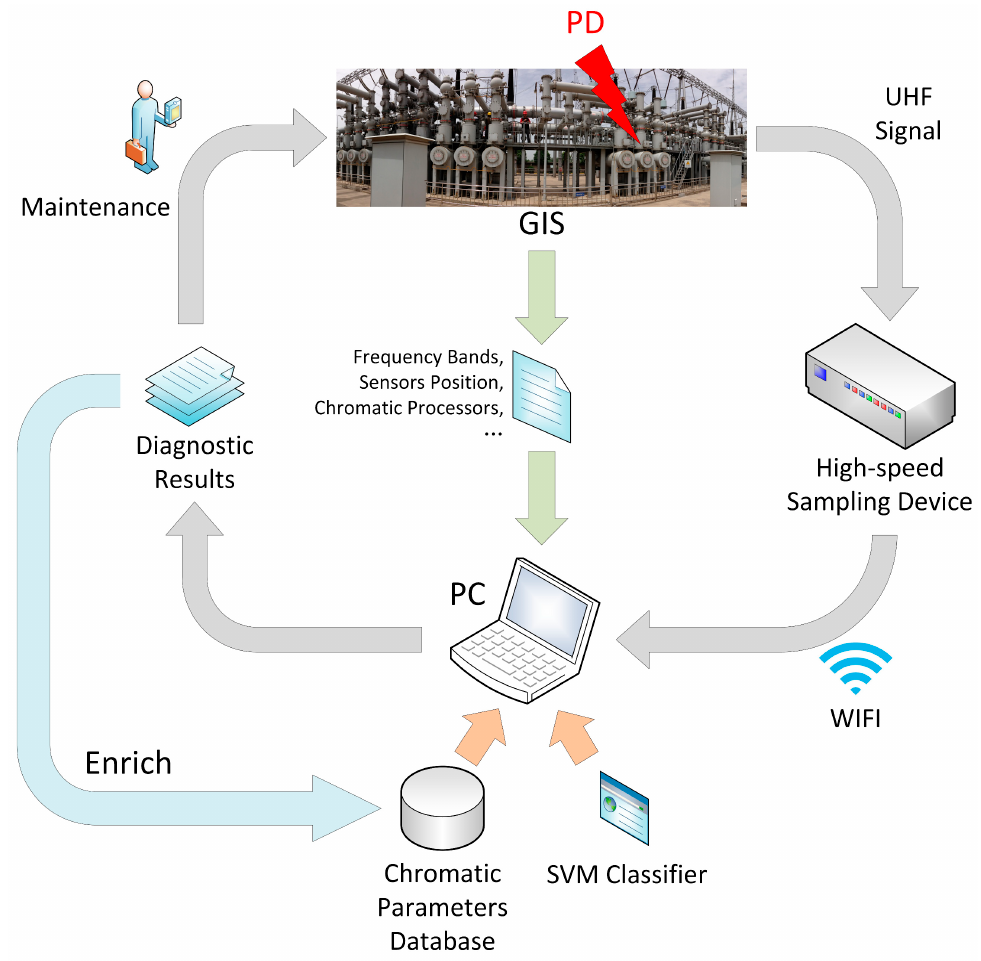
Figure 10. Flow chart of PD pattern recognition using chromatic methodology (GIS: gas-insulated switchgear; PD: partial discharge; UHF: ultra-high frequency; WIFI: wireless fidelity; SVM: support vector machine; PC: personal computer).